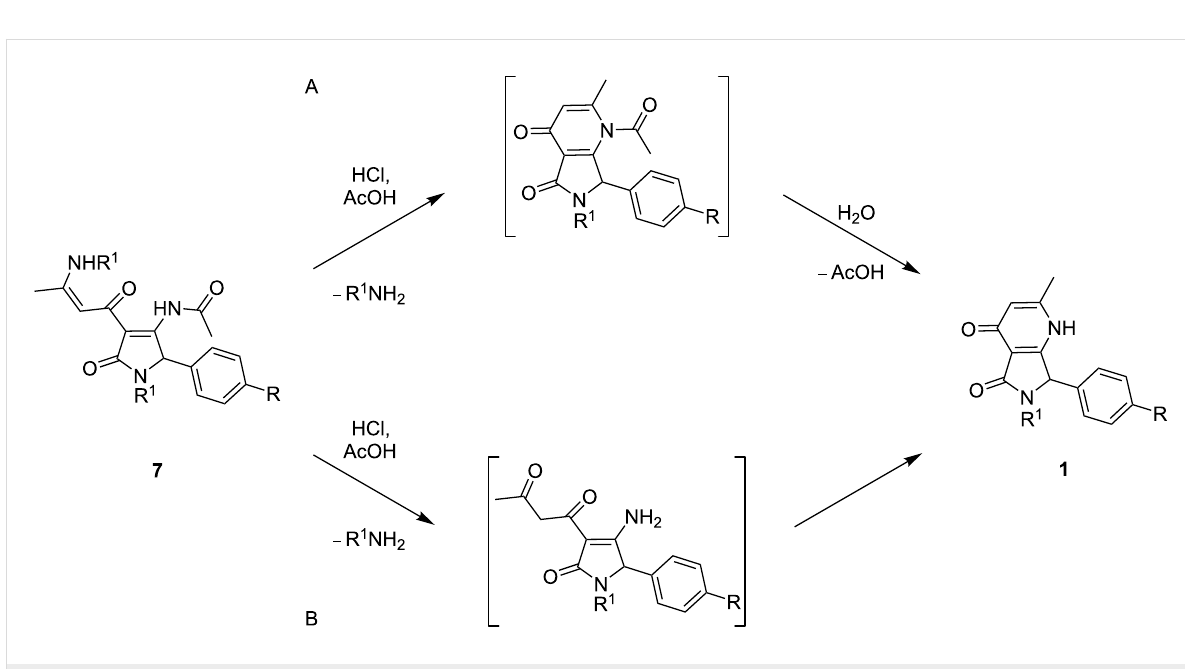
Scheme 4: Possible reaction pathways for the formation of pyrrolo[3,4- b ]pyridin-5-one derivatives 1